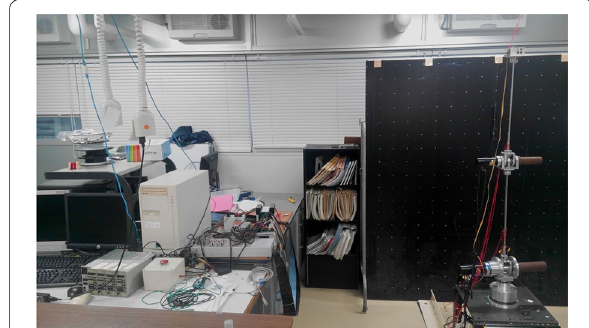
Fig. 8 Experimental setup. On the left, we have the computer hosting the dSPACE and MatLab softwares and from where the experiments are conducted. On the right, we have the two link 3d flexible manipulator